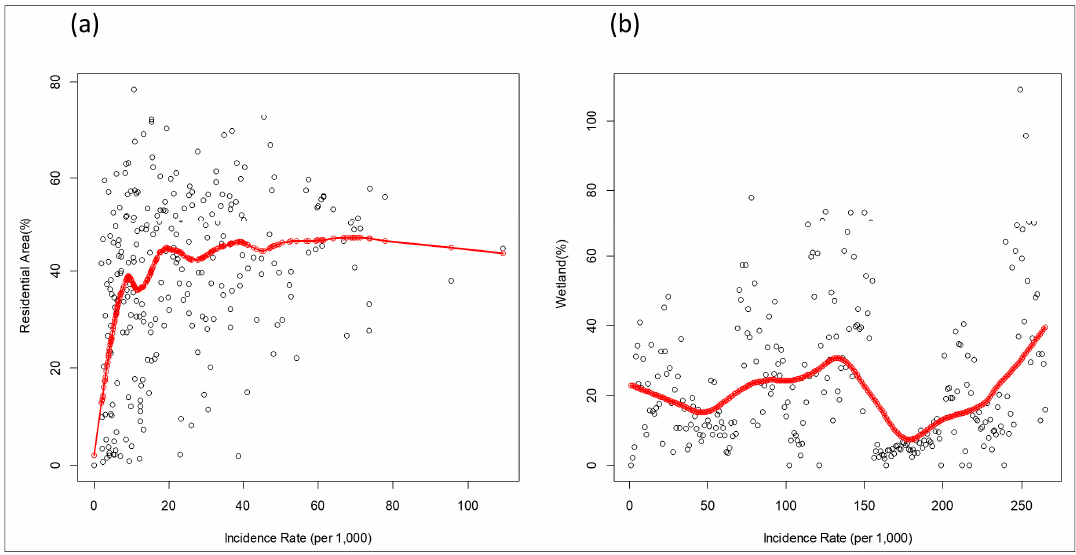
Figure 5. Non ‐ linear relationships between dengue incidence rates (dots) and ( a ) residential area and ( b ) wetland, evaluated by LOWESS technique (red line).